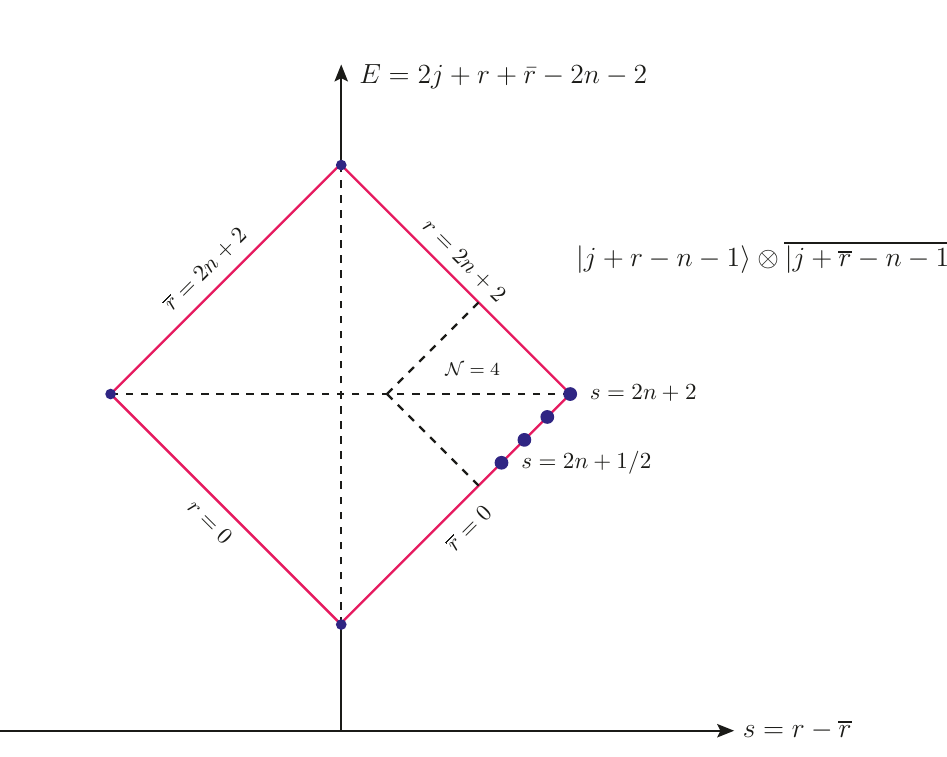
Figure 2 . Schematic description of the discrete physical spectrum for (cid:12)xed n (and (cid:12)xed j ). The four blue dots on the (cid:22) r = 0 edge denote the top component of supermultiplets with the lowest energy for the given spin. See section 4.2 below for a detailed discussion of these